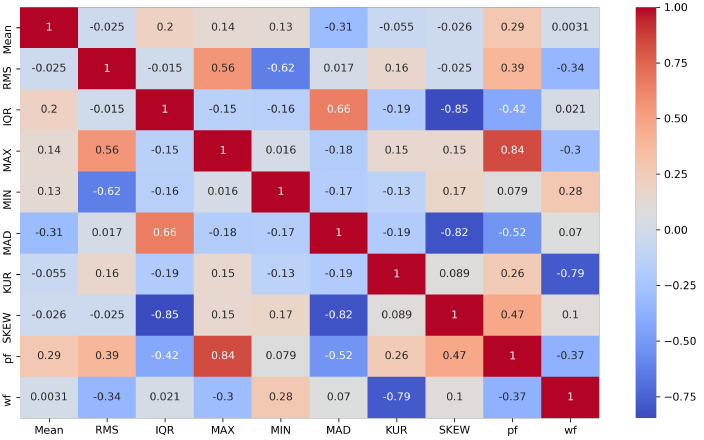
Figure 9. Feature selection plot for the capacitance dataset.